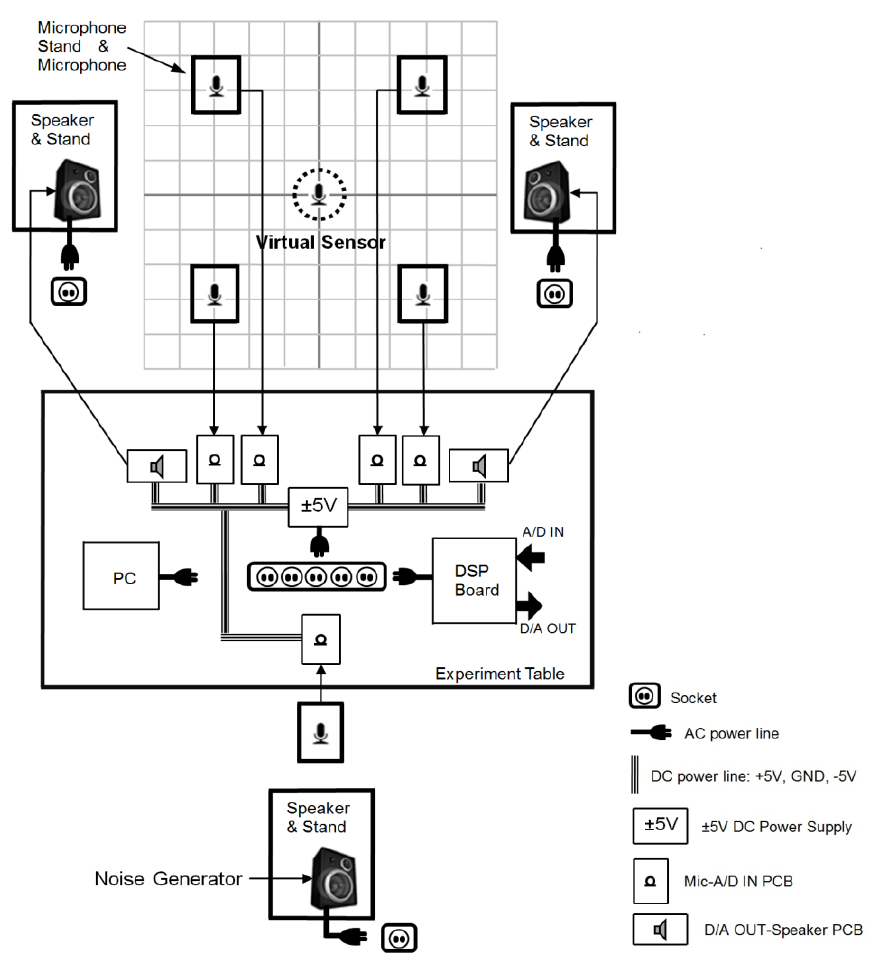
Figure 6. System setup of the proposed ANC system.